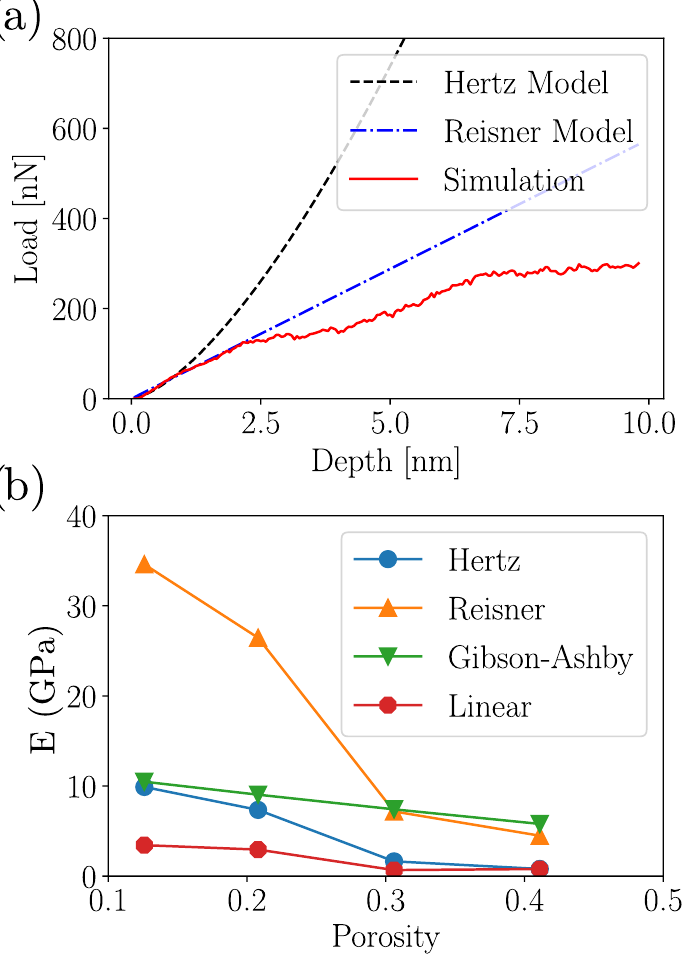
Figure 4. ( a ) Hertz, and Reissner fit from the load–depth curve for φ = 0.128 case. ( b ) Comparison among Hertz, Gibson–Ashby, Reissner, and MD data for Young’s modulus. “Linear” corresponds to a linear fit of the stress–strain curve at strains smaller than 0.01. The Young’s modulus of Au bulk was 78